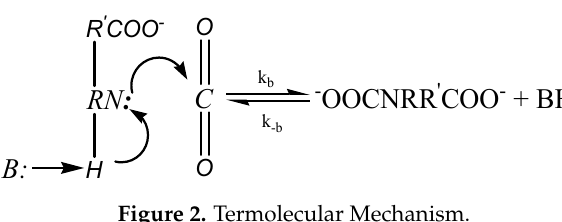
Figure 2. Termolecular Mechanism.